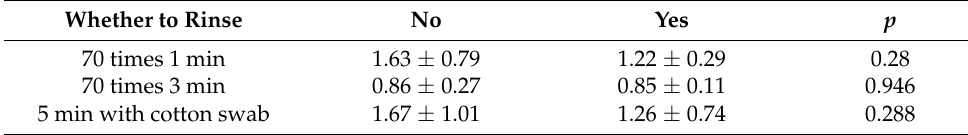
Table 1. The effect of tooth brushing on salivary glucose. (Unit: mmol/L).